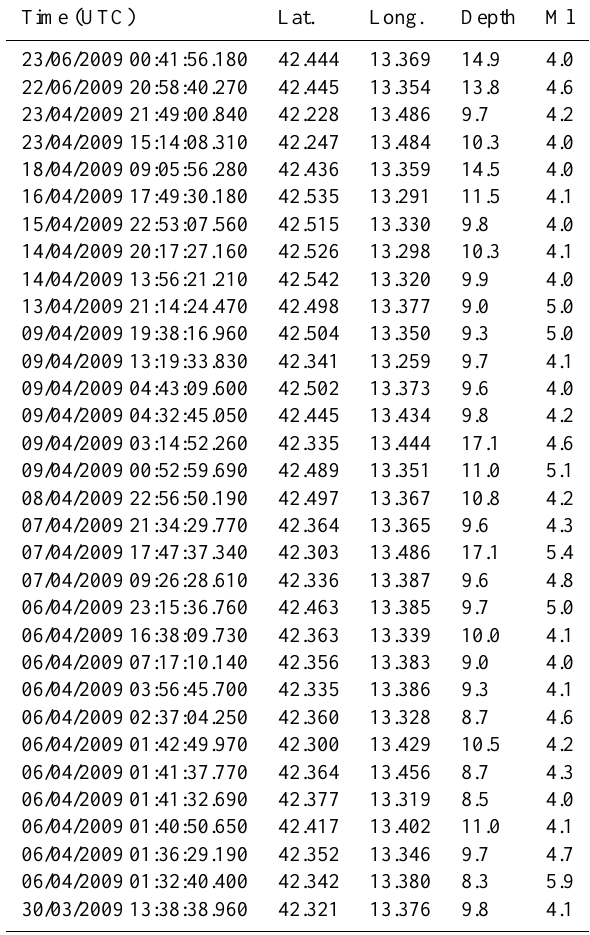
Table 1. List of earthquakes from 30 March 2009 to 23 June 2009 with local magnitudes of Ml >